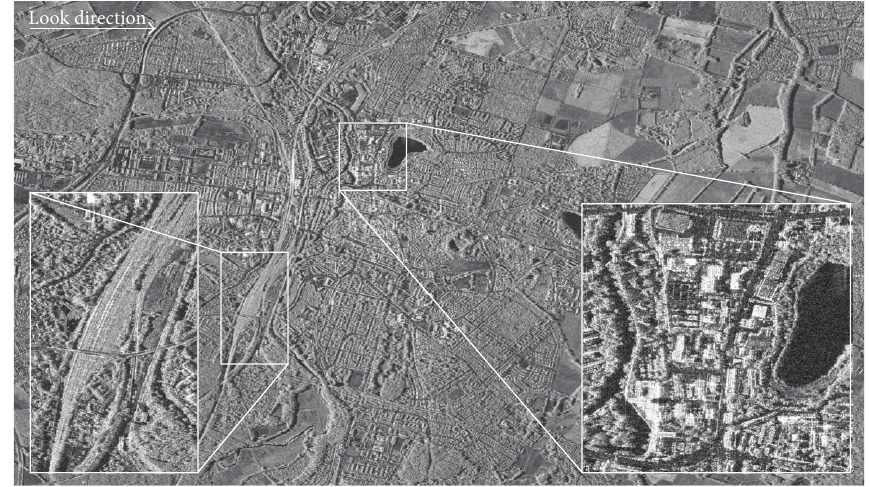
Figure 1: TerraSAR-X Spotlight image (full scene) of L¨uneburg, Germany. Left subset shows a railway station, right subset shows building structures and a pond, © DLR